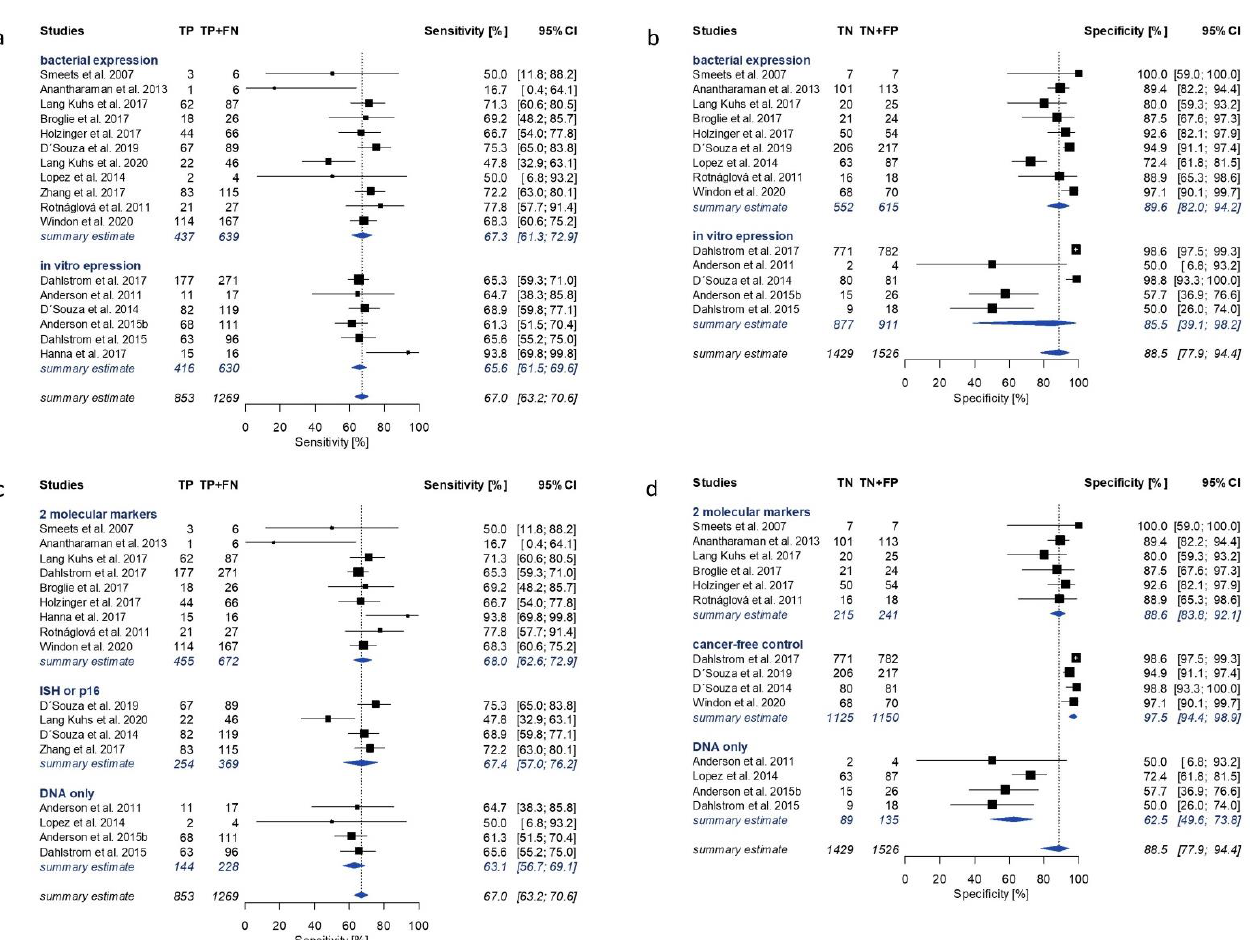
Figure 4. Forest plots of study-specific sensitivity and specificity estimates and summary estimates for HPV16 E7 serology in comparison with molecular HPV tumor status. Pooled estimates were calculated by univariate analysis of log-transformed proportions using a random effects model. Sensitivity of E7 with subgroup summary estimates (I 2 = 37.1% (0.0–64.8%)) was stratified by ( a ) protein expression system and ( c ) reference method. Specificity of E7 with subgroup summary estimates (I 2 = 90.4% (85.7–93.6%)) was stratified by ( b ) protein expression system and ( d ) reference method. TP: true positive; FN: false negative; TN: true negative; FP: false positive; CI: confidence intervals; ISH: in situ hybridization; p16: p16 immunohistochemistry; DNA only: HPV DNA PCR.